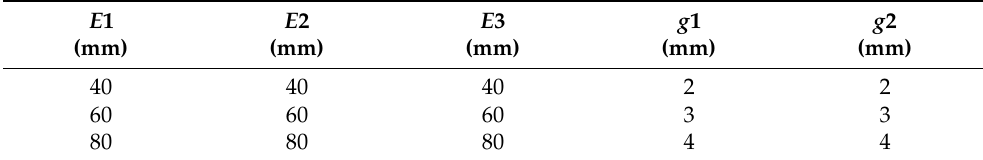
Table 2. Input base variable values.